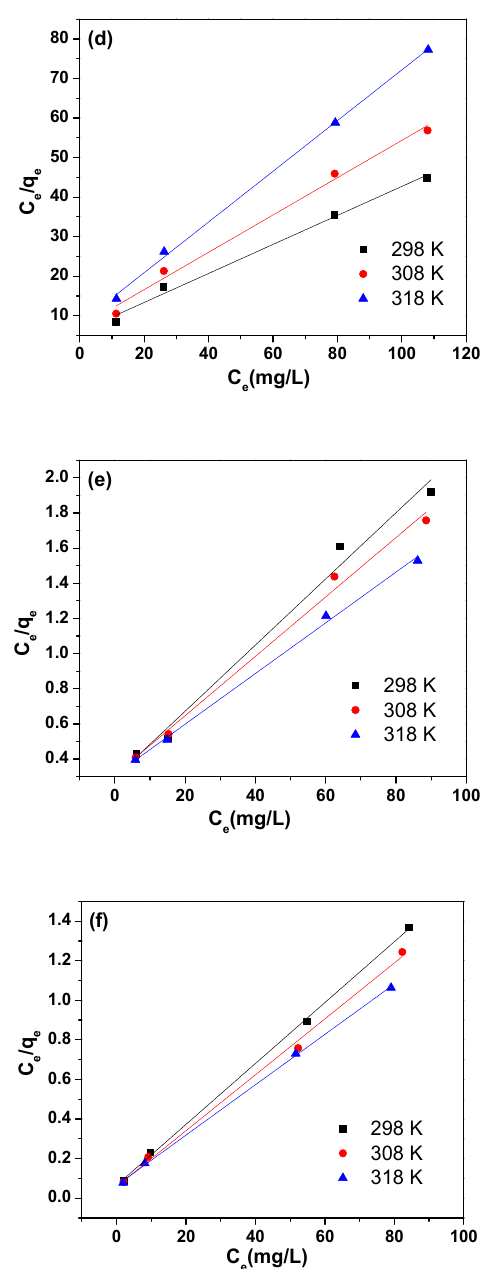
Figure 3. As(III) adsorption by ( a ) GO, ( b ) MIL-53(Al), and ( c ) 3% MIL-53(Al)-GO at different temperatures; Langmuir isotherm models for As(III) adsorption by ( d ) GO, ( e ) MIL-53(Al), and ( f ) 3% MIL-53(Al)-GO.